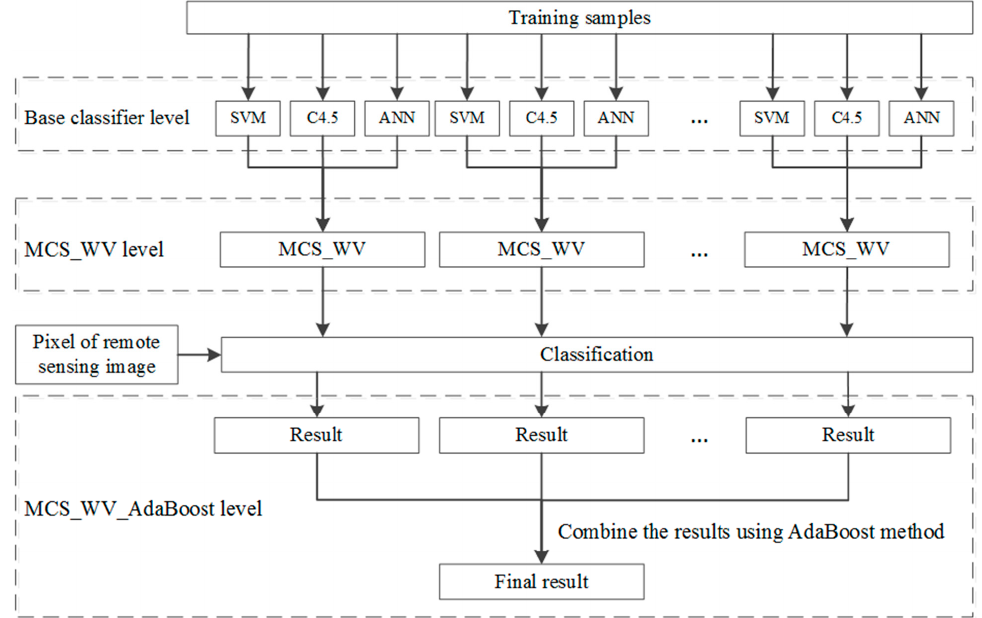
Figure 2. Flow chart of the research procedural route.